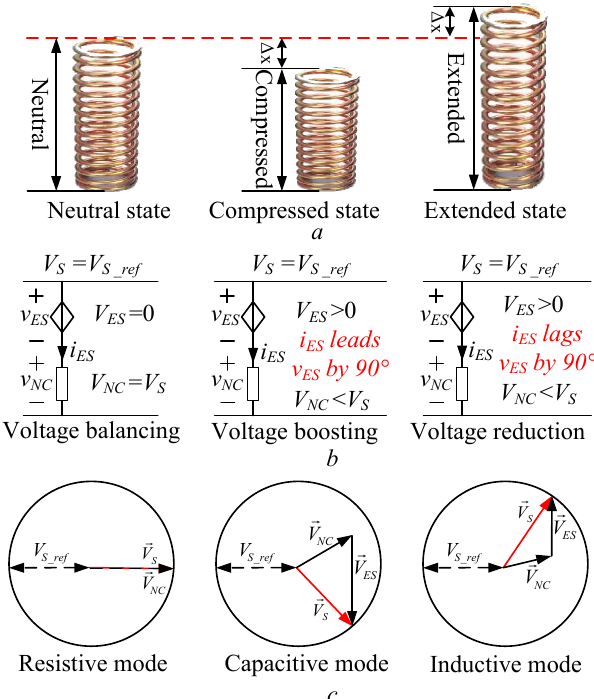
Figure 2. Duality principle from a mechanical spring to an electric spring. ( a ) Mechanical spring; ( b ) Duality principle; ( c ) Operating modes of electric spring.